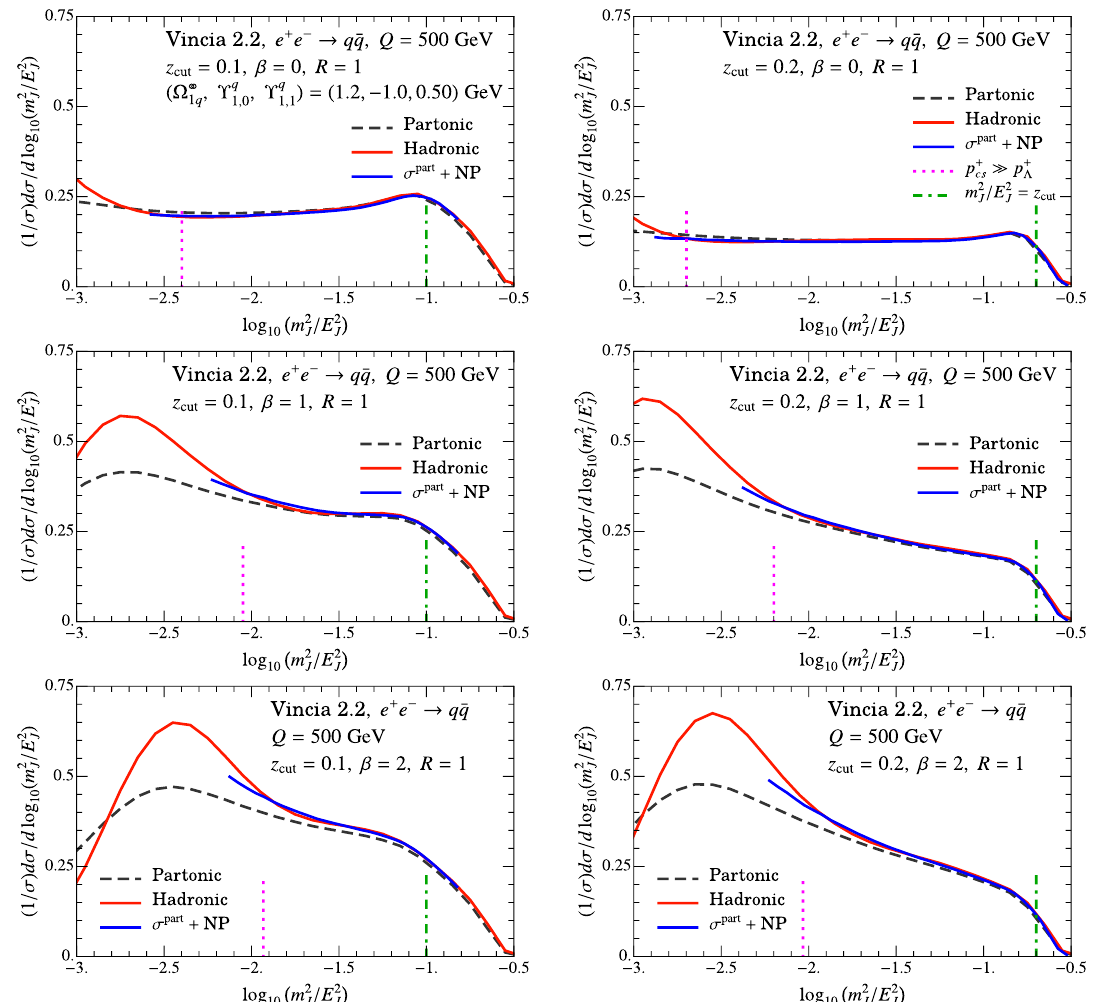
Figure 22 . Fit to hadronic Vincia Monte Carlo in the SDOE region (indicated by the dotted vertical lines) for z cut = 0 : 1 ; 0 : 2 (columns), (cid:12) = 0 ; 1 ; 2 (rows) and Q = 500 GeV. The same values of hadronic parameters displayed in the top left panel are used everywhere else. The vertical dashed and dot-dashed lines delineate the SDOE region as indicated in the top right